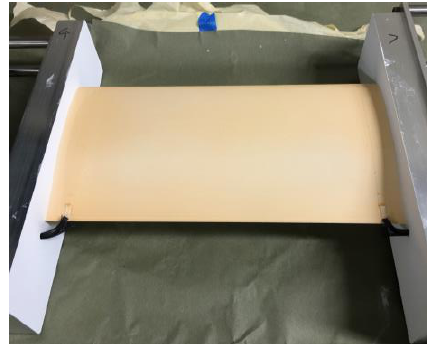
Figure 1. HSNLF(1)-0213 airfoil coated with TSP/CNT.